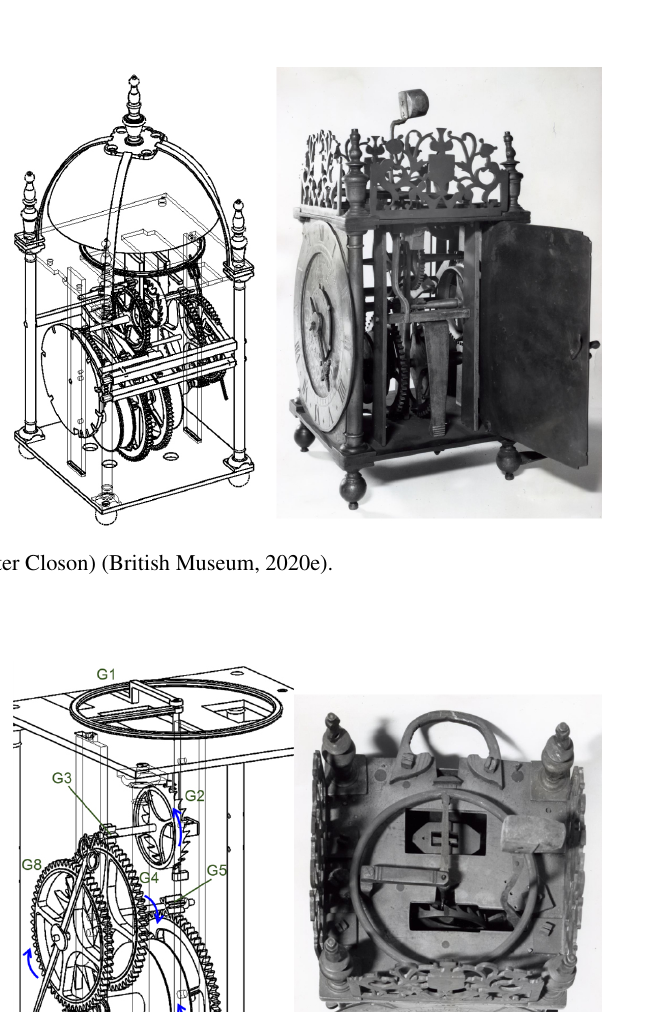
Figure 20. Structure and operation of the N7 striking trigger.